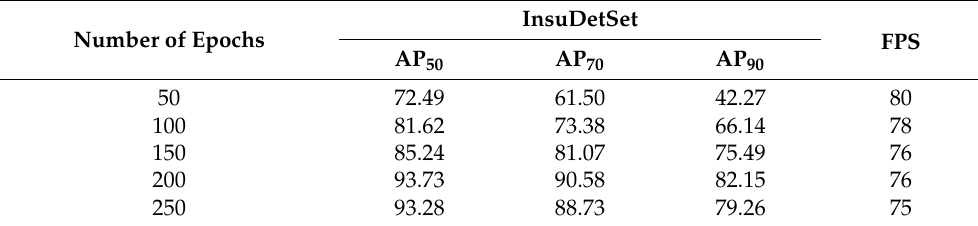
Table 8. APs of different epoch